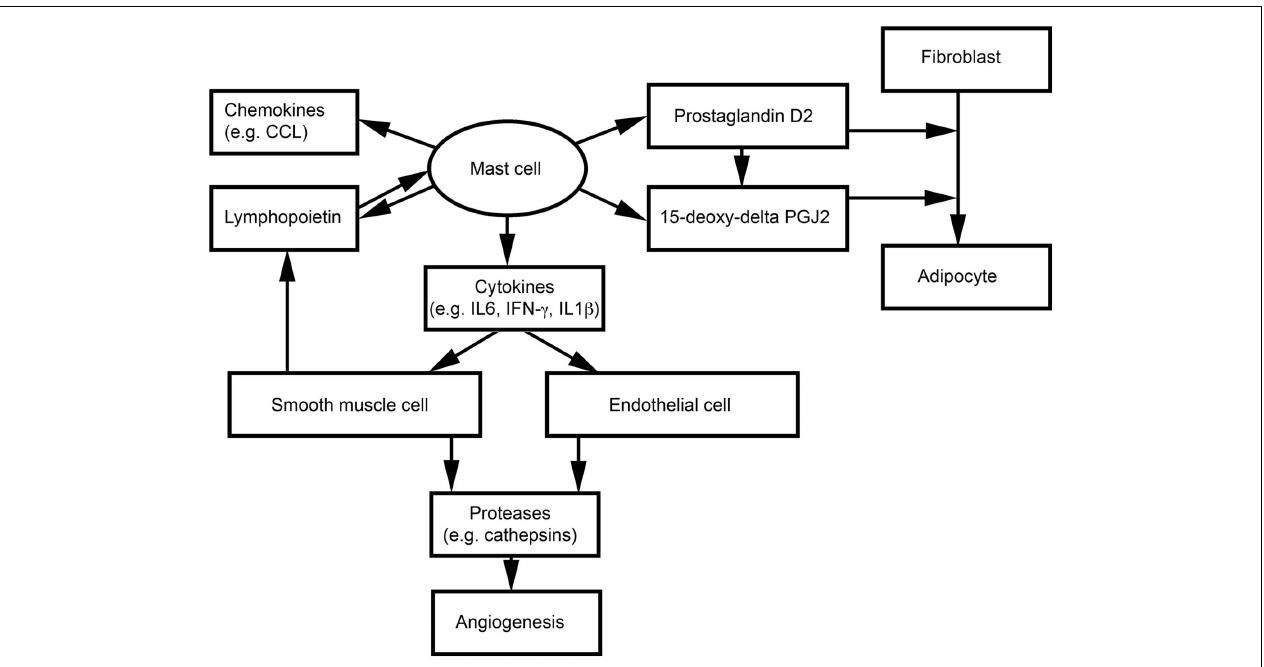
FIGURE 2 | Possible interactions between mast cells and non-inflammatory cells in adipose